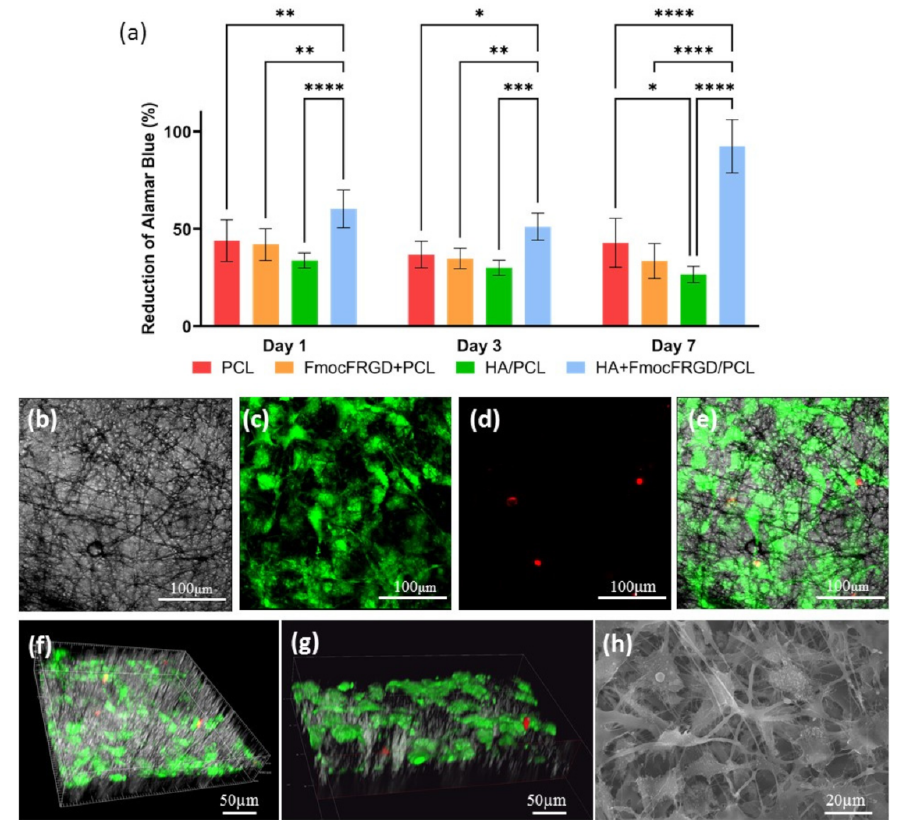
Figure 5. MC3T3-E1 cell viability and spreading on HA + FmocFRGD/PCL core/shell electrospun fibers. ( a ) Number of viable MC3T3-E1 cells at different time points evaluated by Alamar blue. ( b – e ) MC3T3-E1 cells cultured for three days on an HA + FmocFRGD/PCL core/shell scaffold and stained with fluorescein diacetate and propidium iodine. ( f – g ) 3D reconstruction of an HA + FmocFRGD/PCL core/shell scaffold. ( h ) SEM image of MC3T3-E1 cells on an HA + FmocFRGD/PCL core/shell scaffold. Data were analyzed by using two-way ANOVA. * p < 0.05, ** p < 0.01, *** p < 0.001, and **** p <